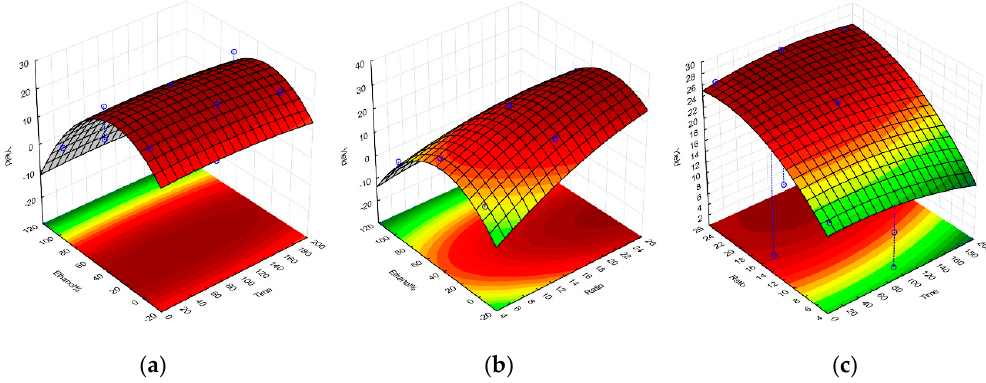
Figure 4. Response surface graphs for the model of the G. gracilis extractions, obtained for the Yield response upon variation of ethanol% and extraction time ( a ), ethanol% and solid-to-liquid ratio ( b ), and solid-to-liquid ratio and extraction time ( c ). Yield is expressed as a percentage of dry weight. Time is expressed in minutes, and SLR (here displayed as Ratio) as solvent volume (mL) per one gram of dried